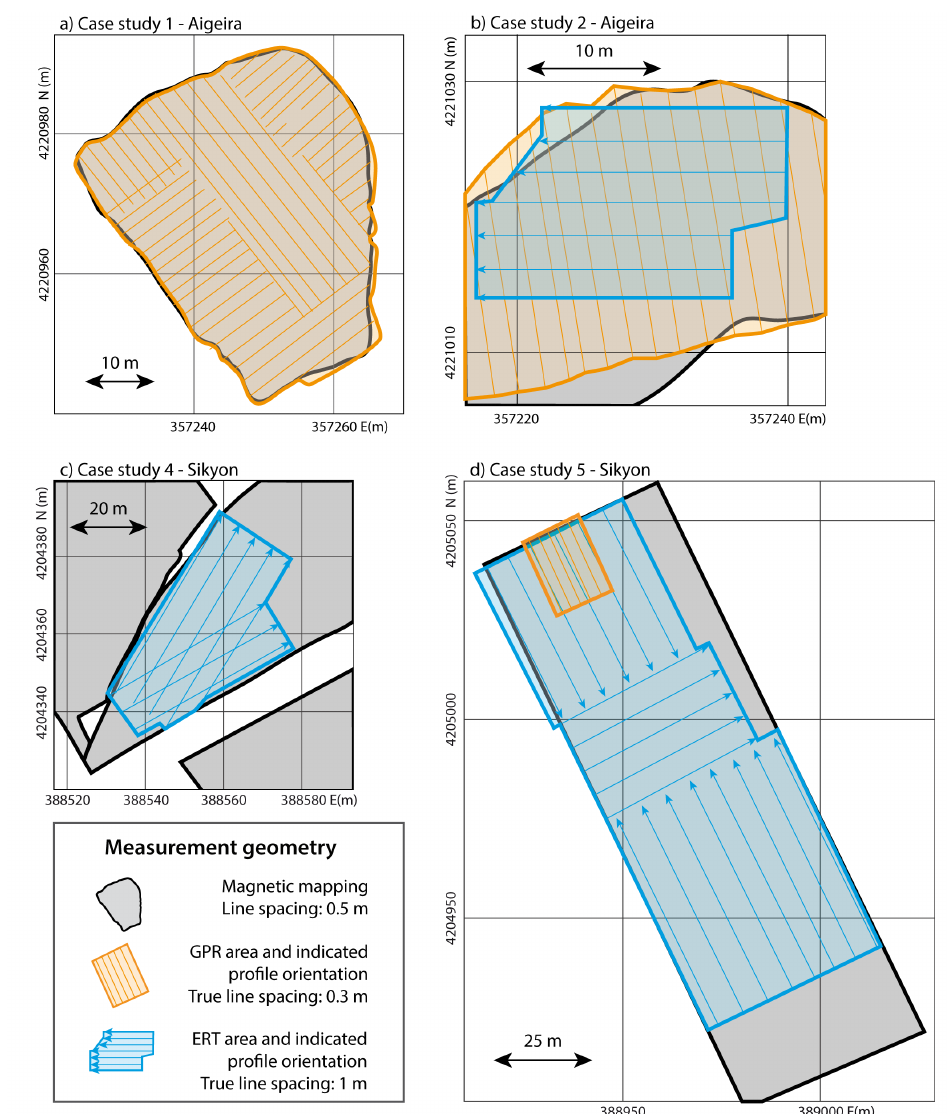
Figure 3. Overview over the measurements arrangements of magnetic mapping, ground-penetrating radar (GPR), and electrical resistivity tomography (ERT). For the case studies 1, 2, 4, 5 the arrangement of the measuring areas with indicated profile orientations is shown. The location and orientation of the seismic profiles of case study 3 and 6 can be taken from the corresponding result illustrations in Sections 5.3 and